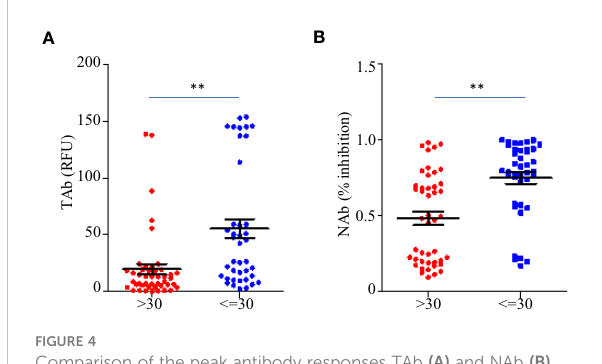
FIGURE 4 Comparison of the peak antibody responses TAb (A) and NAb (B) between participants younger than 30 years old (n=40) and older (n=45) before the booster shots. The horizontal lines indicated the medians and the error bards indicted the IQRs. ** p<0.01, Mann- Whitney